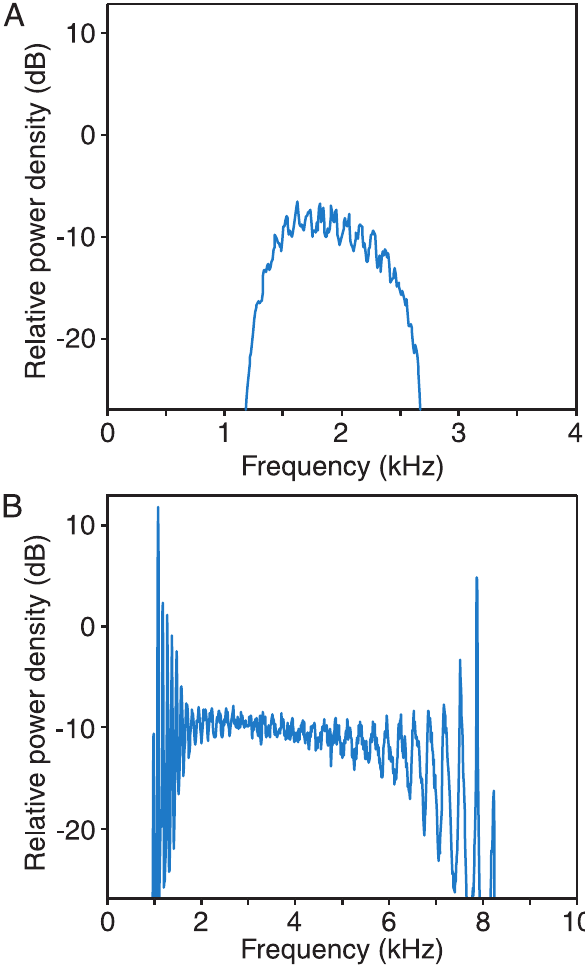
Figure 4. The effect of boundary conditions. A. For a system in which the amplitude of free-running oscillation a varies parabolically across the array, the power spectrum displays poorly defined peaks owing to the absence of sharp boundaries between oscillating groups. B. For a lengthened chain of 210 oscillators, the power spectrum shows sharp peaks produced by oscillators near the boundaries of the basilar papilla, but a poorly defined structure at the frequencies represented by oscillators in the chain’s middle. The frequencies are exponentially distributed over an extended range, from 1 to 8.06, owing to the increased length of the